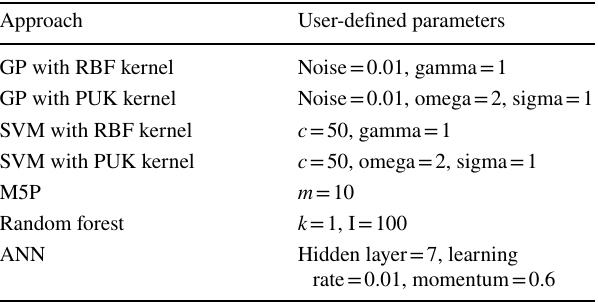
Table 4 User-defined parameters of training and testing dataset Approach